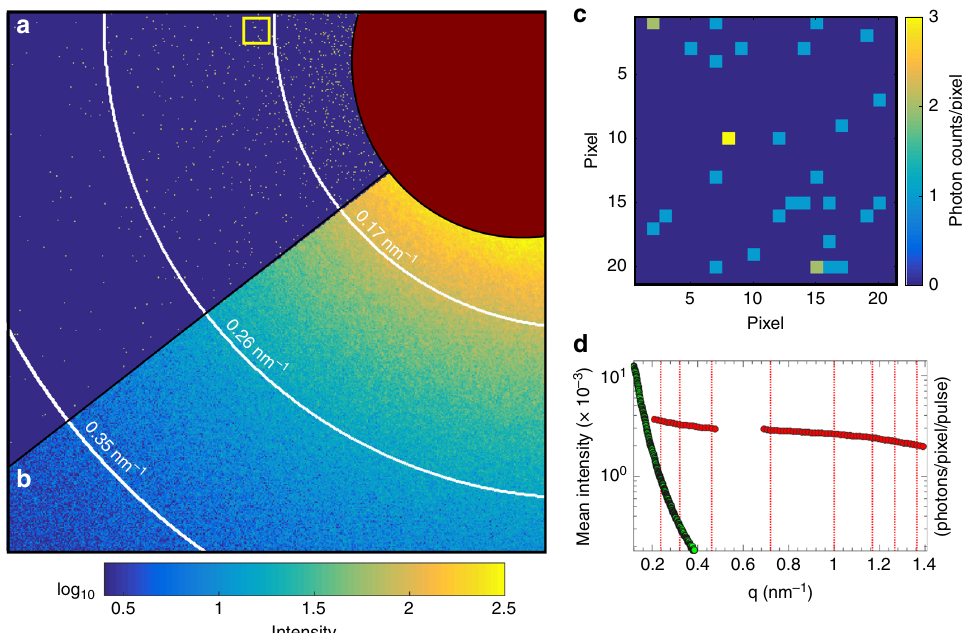
Fig. 2 2D speckle pattern. a Single split-pulse scattering pattern. b Sum of 2.5 × 10 3 scattering patterns. The brown circular area corresponds to the beamstop, which was masked in the data analysis process. c Signal of single (blue), double (green) and triple (yellow) photon events in a 22 by 22 pixel region of interest (shown by the yellow square in a ). d Azimuthally integrated intensity of the summed scattering patterns collected from the static sample (green). Red circles denote the integrated intensity collected from the dynamic gold sample at two detector positions